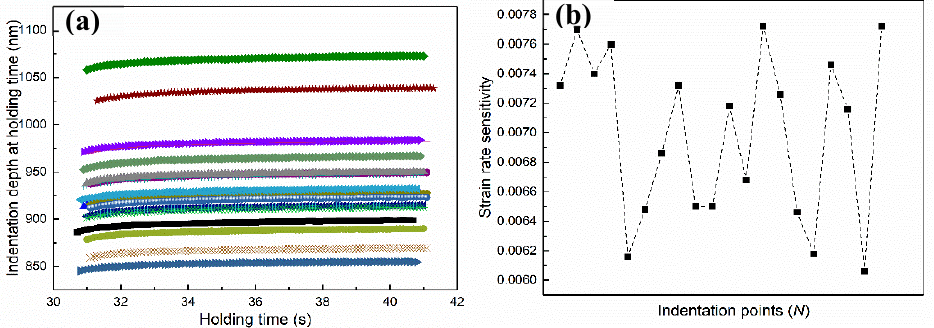
Figure 5. Indentation depth as a function of holding time ( a ) and the calculated strain rate sensitivity ( b ) of NiCoCrAlYCe coatings.